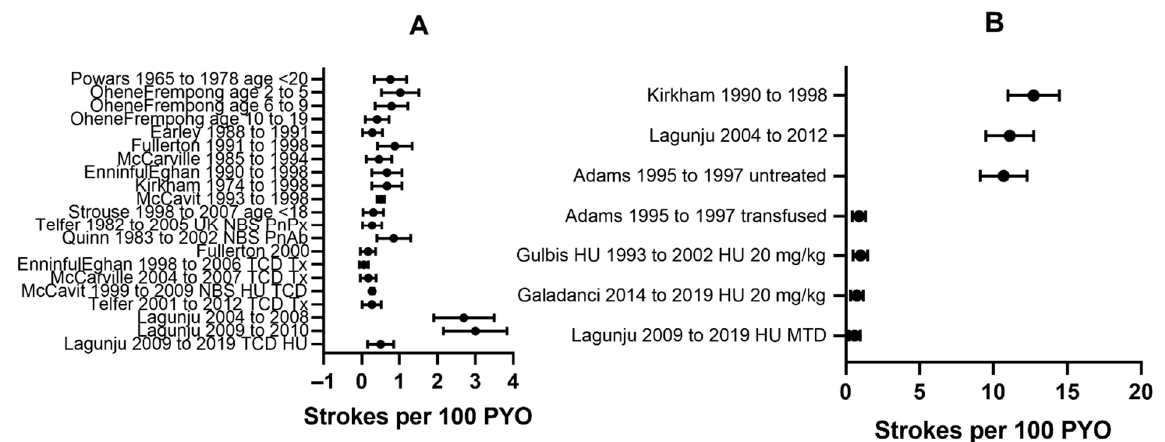
Figure 1. Incidence of Stroke in unscreened children with sickle cell disease ( A ) and in children with SCD with abnormal Transcranial Doppler ( B ). NBS Newborn screening PnPx Pneumococcal prophylaxis with Penicillin and vaccination PnAb Pneumococcal prophylaxis with Penicillin PC Personal Communication TCD Transcranial Doppler screening and treatment. HU Hydroxyurea. MTD Maximum tolerated dose.